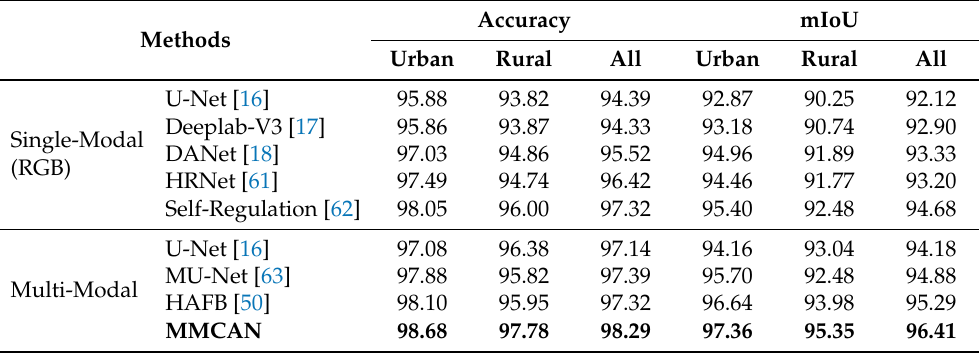
Table 1. Performance on the HSI Road validation set, divided into three conditions: urban scenes, rural scenes, and all scenes.